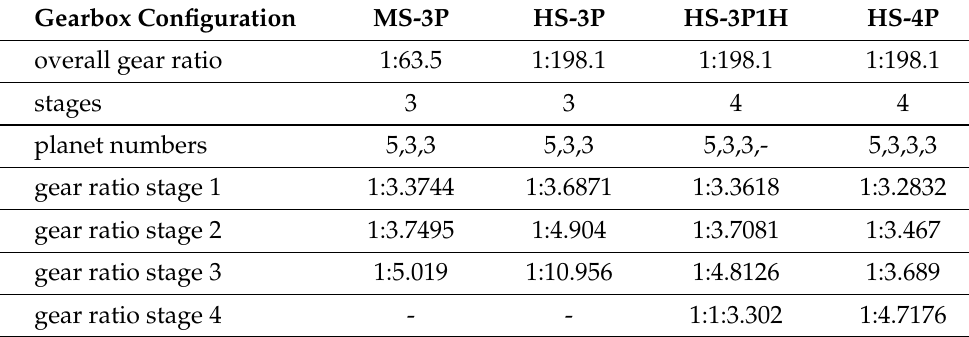
Table 4. Gearbox stage ratio optimization